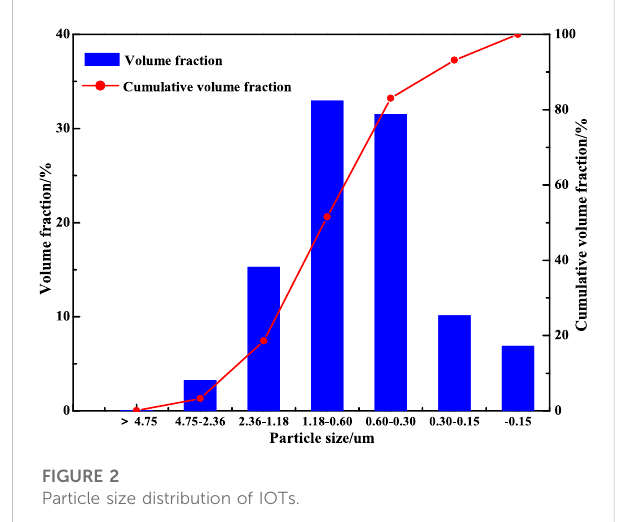
Fitting curve of SSA of SS at different grinding